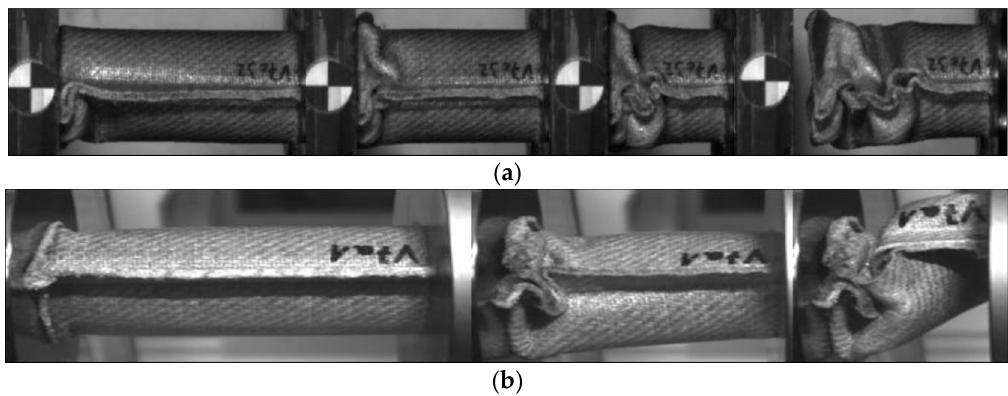
Figure 20. Failures mechanism for V7 in: ( a ) b and c series. ( b ) Quasi-static tests a series.